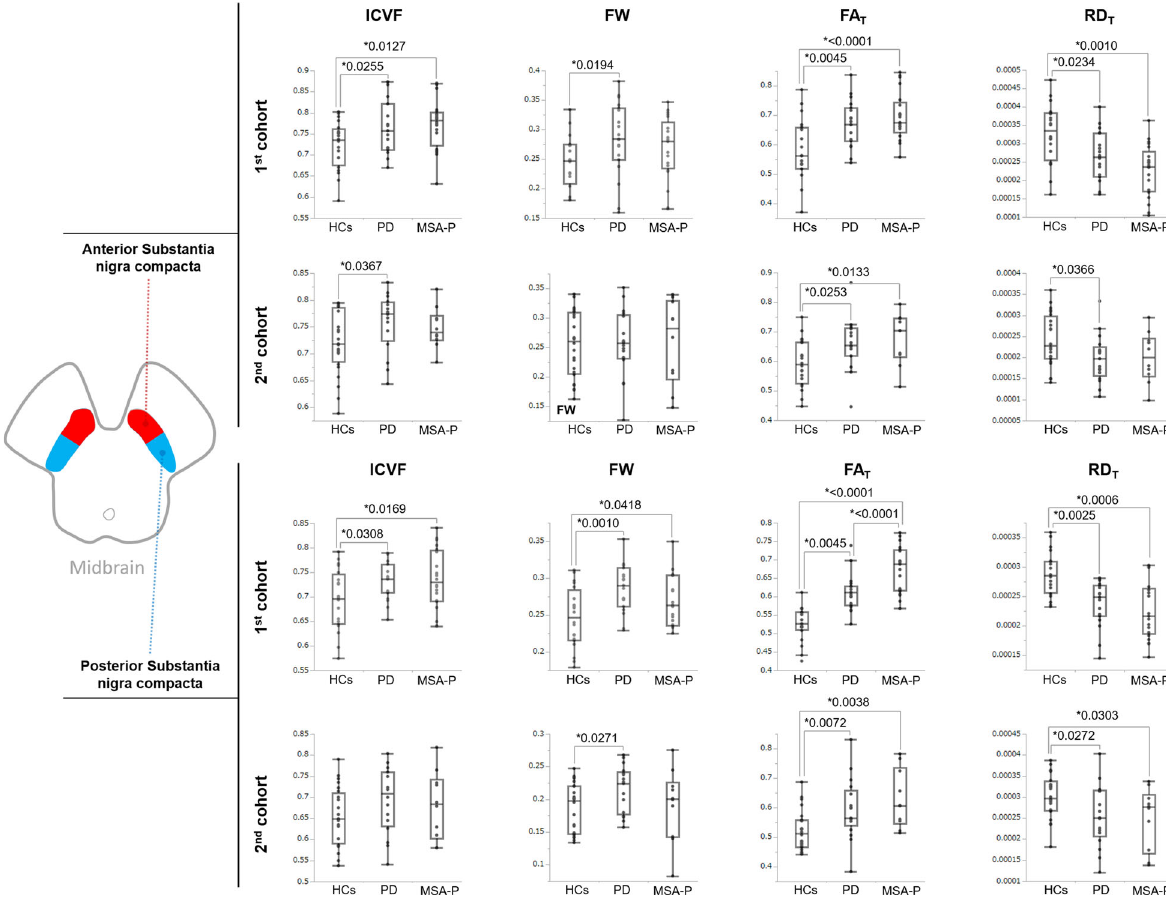
Fig. 4 Results of the nigral ROI analysis. In the fi rst cohort, both aSN and pSN showed signi fi cantly higher ICVF and FA T , and signi fi cantly lower RD T in the MSA-P and PD patients compared with the HCs. The FW was signi fi cantly higher in aSN of PD patients compared with HCs, whereas the pSN showed signi fi cantly higher in both MSA-P and PD patients compared with HCs (Supplementary Table 4). Similar results were observed in the second cohort, especially in the FAT and RDT (Supplementary Table 4). In the boxplot, the center line represents the median, the box represents the third quartile, and the whiskers represent the maximum and minimum values. Abbreviations: FW free water, ICVF intracellular volume fraction, MVF myelin volume fraction, pSN posterior part of SNc, RD T free water-corrected radial diffusivity, aSN anterior part of SNc, SNc substantia nigra pars